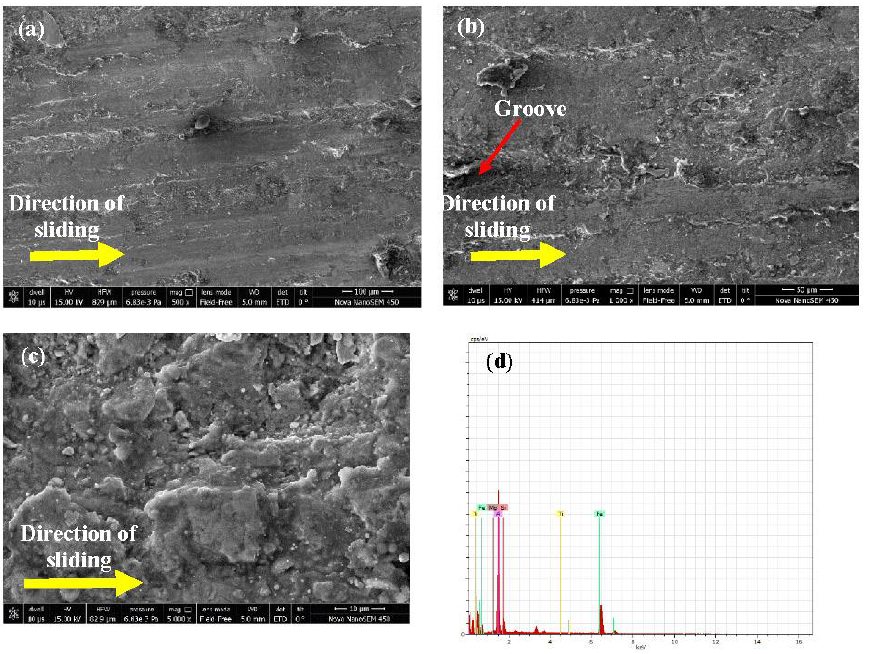
Fig. 12. (a), (b), (c) FESEM images of Al-Si-Mg/TiB 2 composites at 9 h ageing time, 2.5 m/s sliding speed and 24.52 N, (d) EDS mapping of Al-Si-Mg/TiB 2 composites at 9 h ageing time, 2.5 m/s sliding speed and 24.52